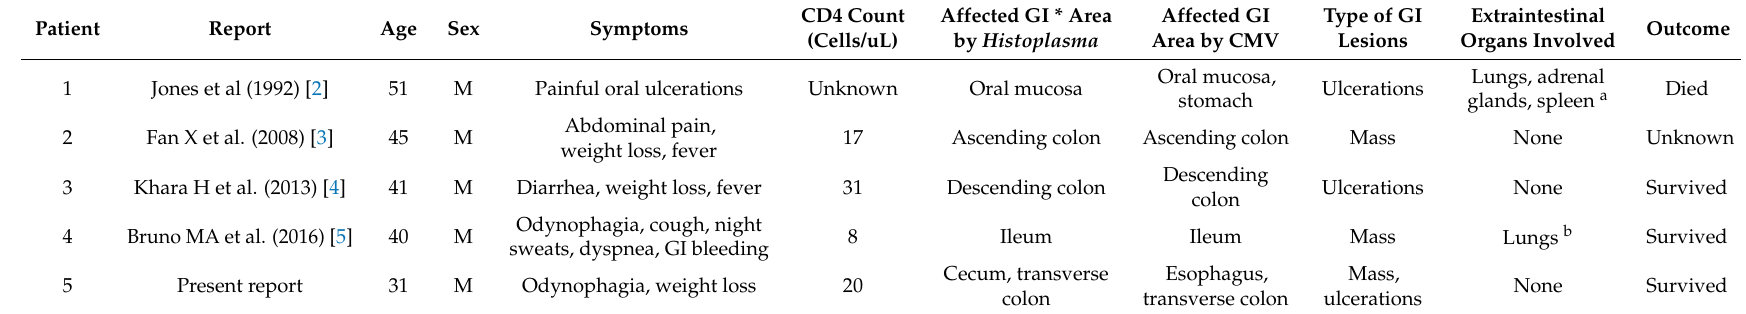
Table 1. Summary of Cases Reported in the Literature for CMV and Histoplasma Co-infection of the gastrointestinal tract in patients with